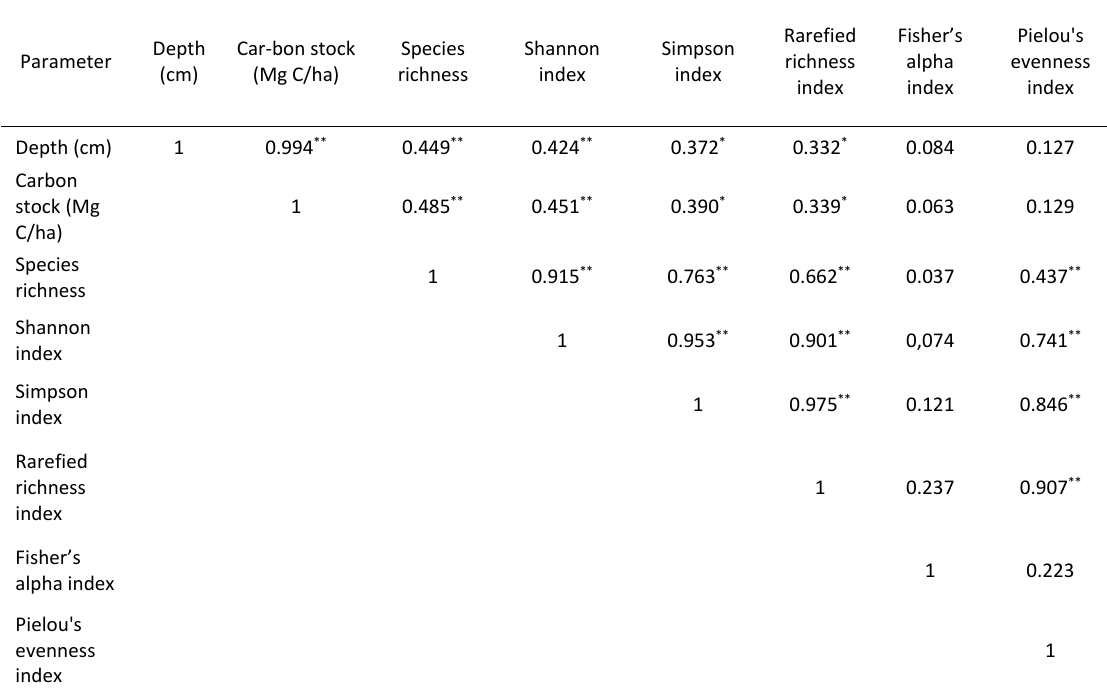
Table 8: Pearson correlation values between peat depth, vegetation diversity, and carbon stock.